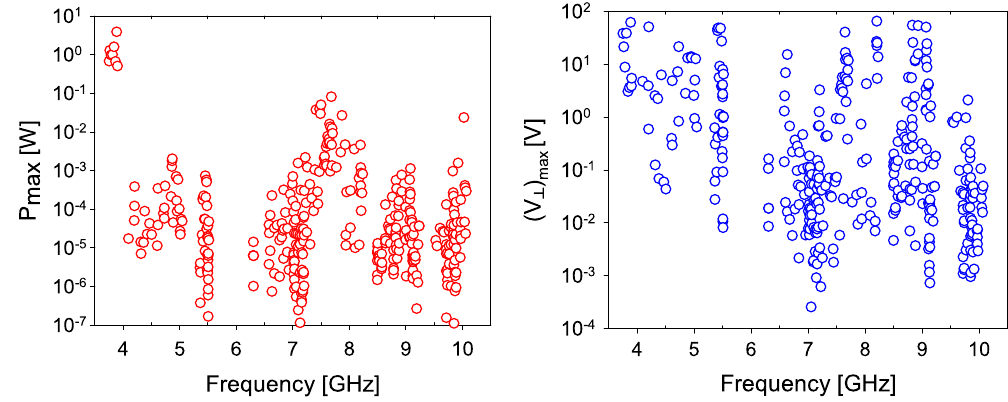
FIG. 6. Resonant HOM excitation, average power (left) and transverse voltage (right), of the ideal 3.9 GHz LCLS-II